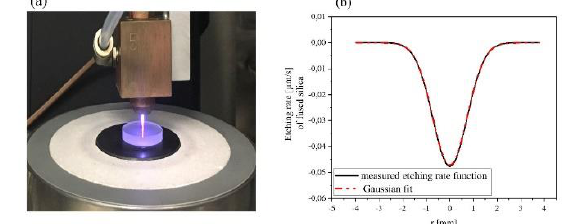
Fig. 1. (a) Plasma jet on substrate, (b) Typical plasma jet etching tool function on fused silica.